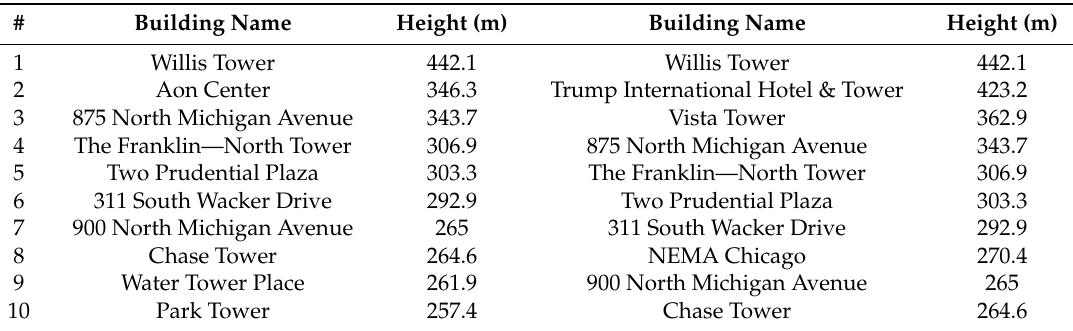
Figure 10. Chicago in 2000 and 2020. Table 20. Chicago’s 10 tallest skyscrapers in 2000 and 2020.